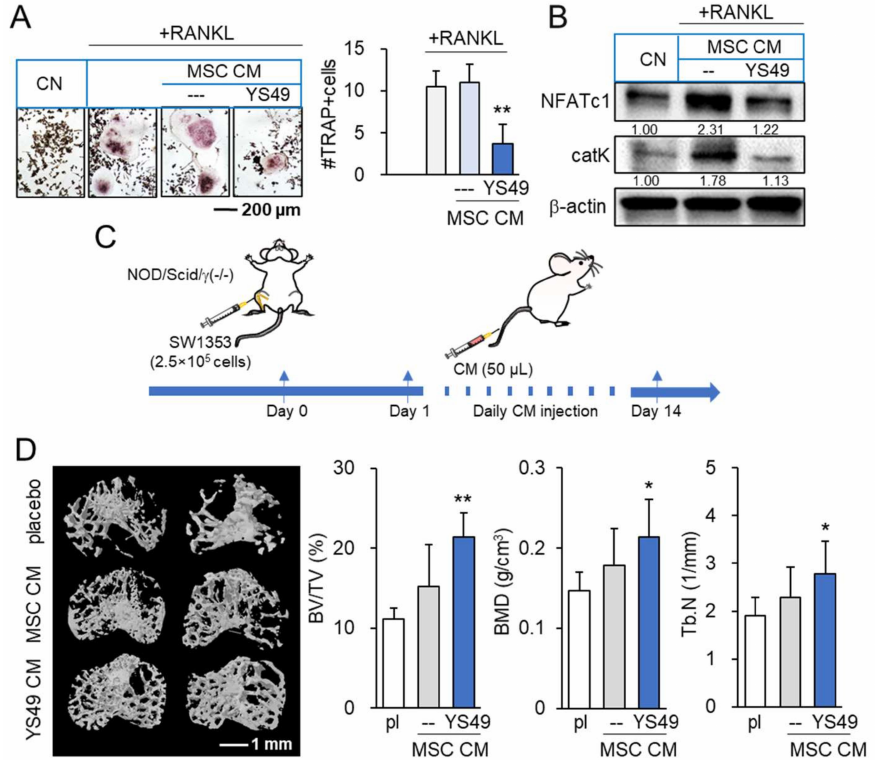
Figure 7. Suppression of osteoclast development and CS-driven bone loss by YS49-treated MSC- derived conditioned medium. pl = placebo, CM = conditioned medium, and YS49 CM = YS49-treated MSC-derived CM. The concentration of YS49 was 50 µ M. The single and double asterisk indicate p < 0.05 and 0.01, respectively. ( A , B ) Suppression of osteoclast development and downregulation of NFATc1 and cathepsin K by YS49 CM ( n = 6). ( C ) Timeline of the animal experiment. SW1353 cells were injected into the tibiae of NOD/SCID/ γ ( − / − ) (NSG) female mice (8 mice per group). The administration of CM began on day 1 after the injection. YS49 CM was given daily as an intravenous injection to the tail vein. Mice were sacrificed in 14 days. ( D ) Reduction in trabecular bone loss in the CS-invaded proximal tibia by YS49 CM. BV/TV = bone volume ratio, BMD = bone mineral density, Tb.N = trabecular number, and Tb.Sp = trabecular separation ( n = 8). Full Western blot images are available in Figure